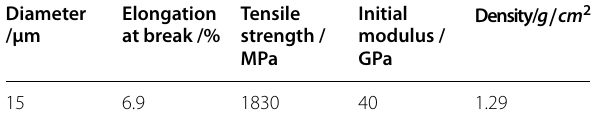
Table 2 Physical and mechanical properties of PVA fibers. Diameter /μm